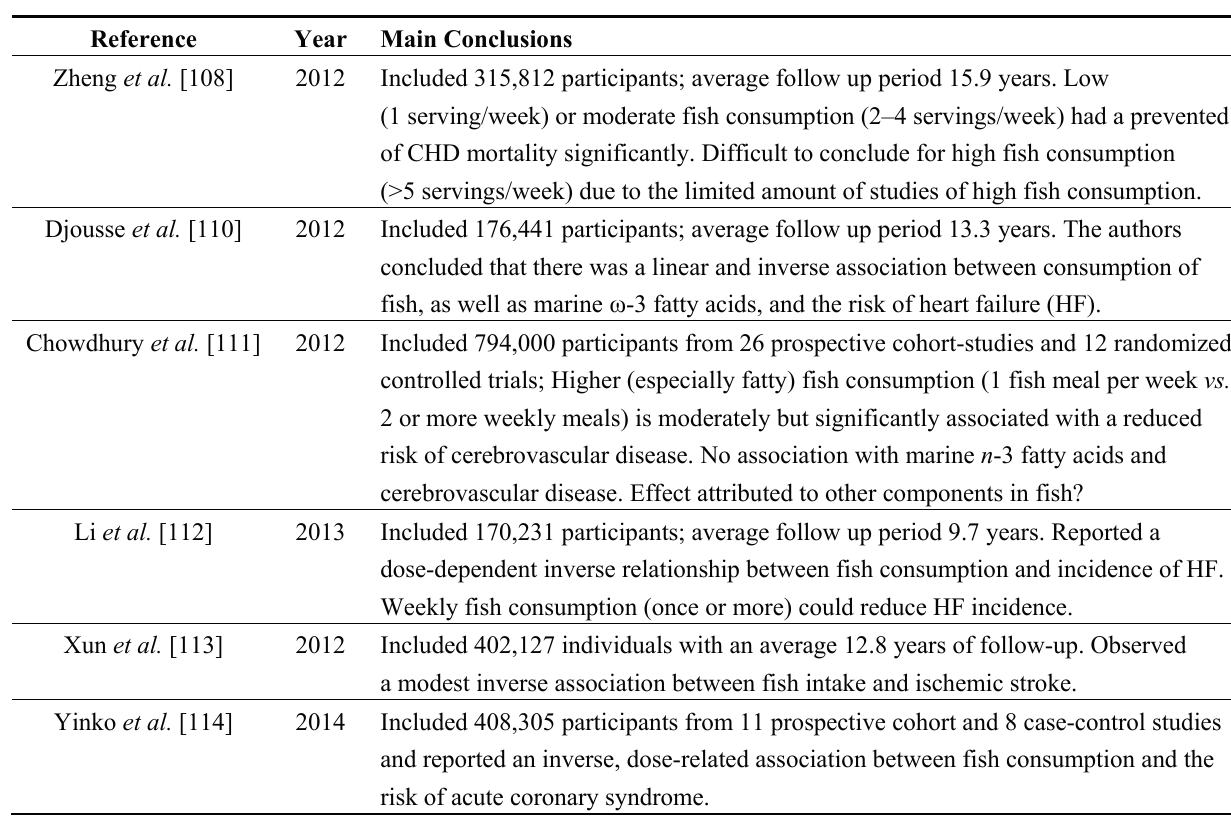
Table 1. Recent systematic reviews and meta-analyses evaluating the association between the consumption of fish and risk of cardiovascular disease.